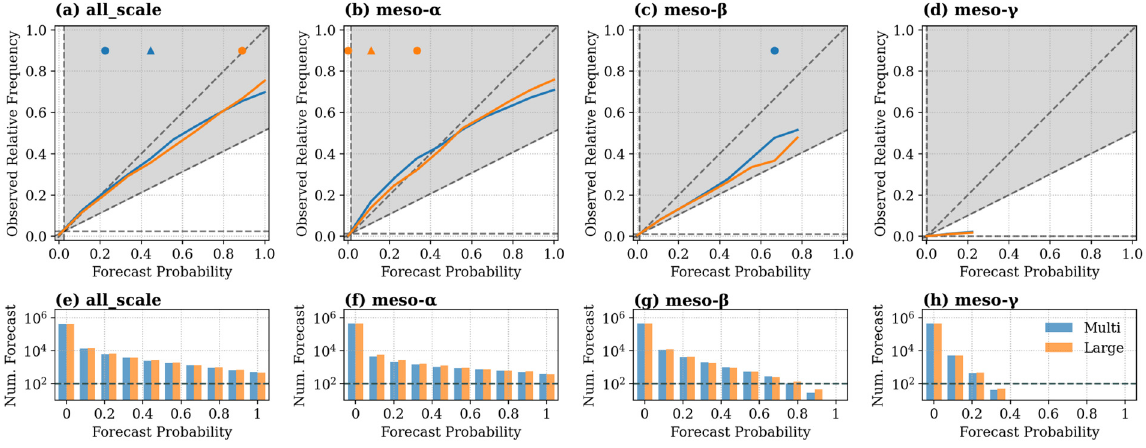
Figure 13. As in Figure12, but for 7–12h forecasts (a–h). 535